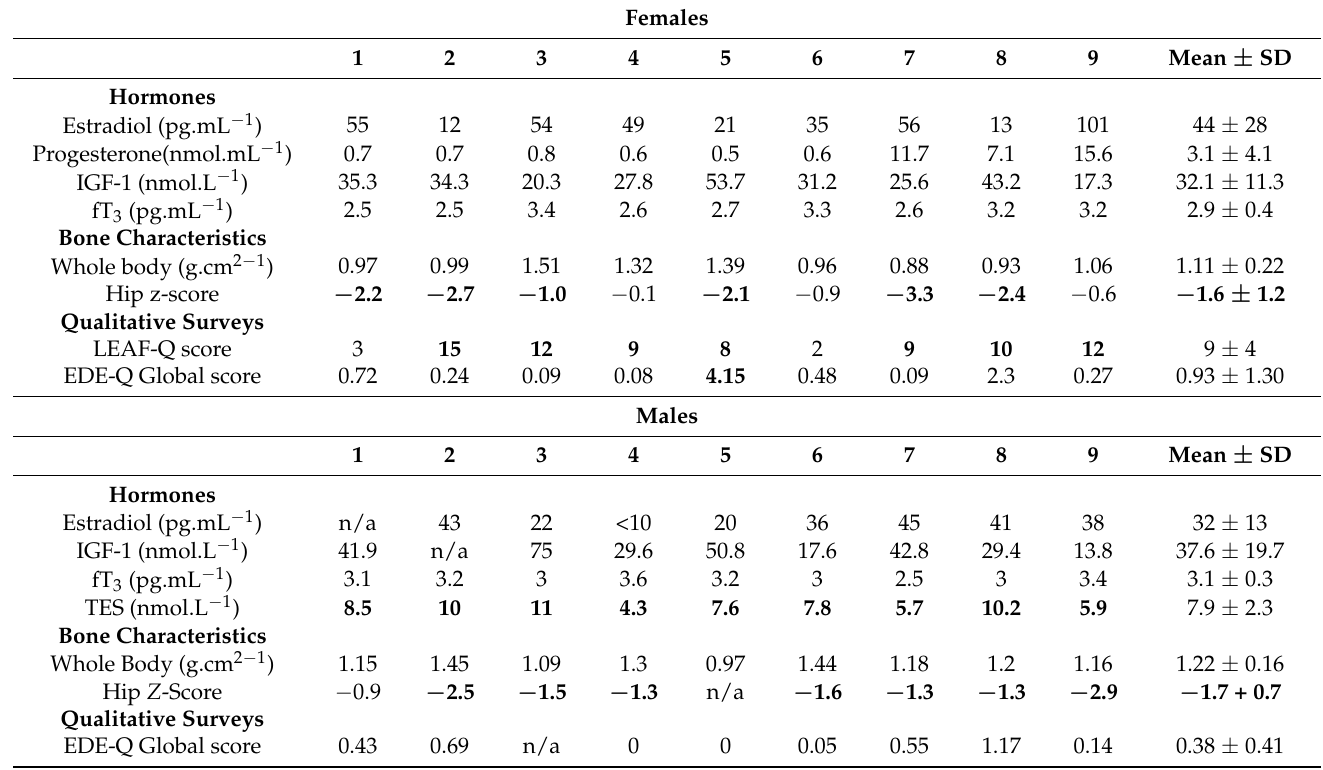
Table 3. Metabolic and reproductive hormone concentrations, bone density, and qualitative survey data for each participant.